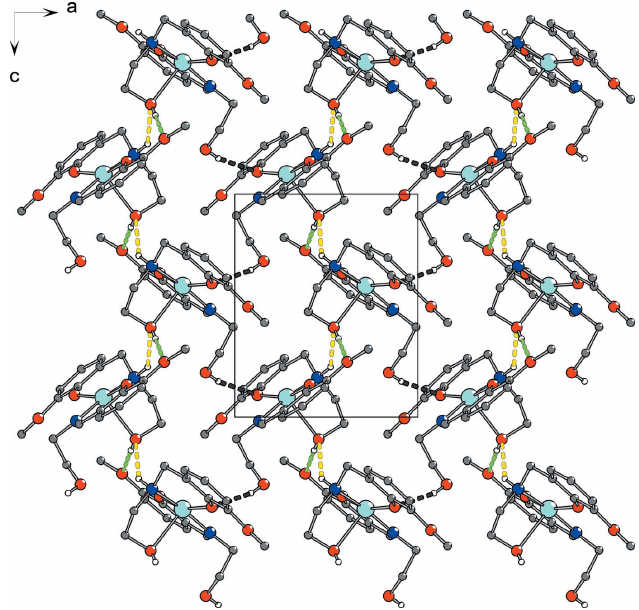
Figure 3 The hydrogen-bonded sheet extending parallel to (010) in the crystal structure of (I). N—H (cid:2)(cid:2)(cid:2) O (yellow) and O—H (cid:2)(cid:2)(cid:2) O hydrogen bonds through participation of coordinating (green) and free (black) hydroxy- ethyl groups are